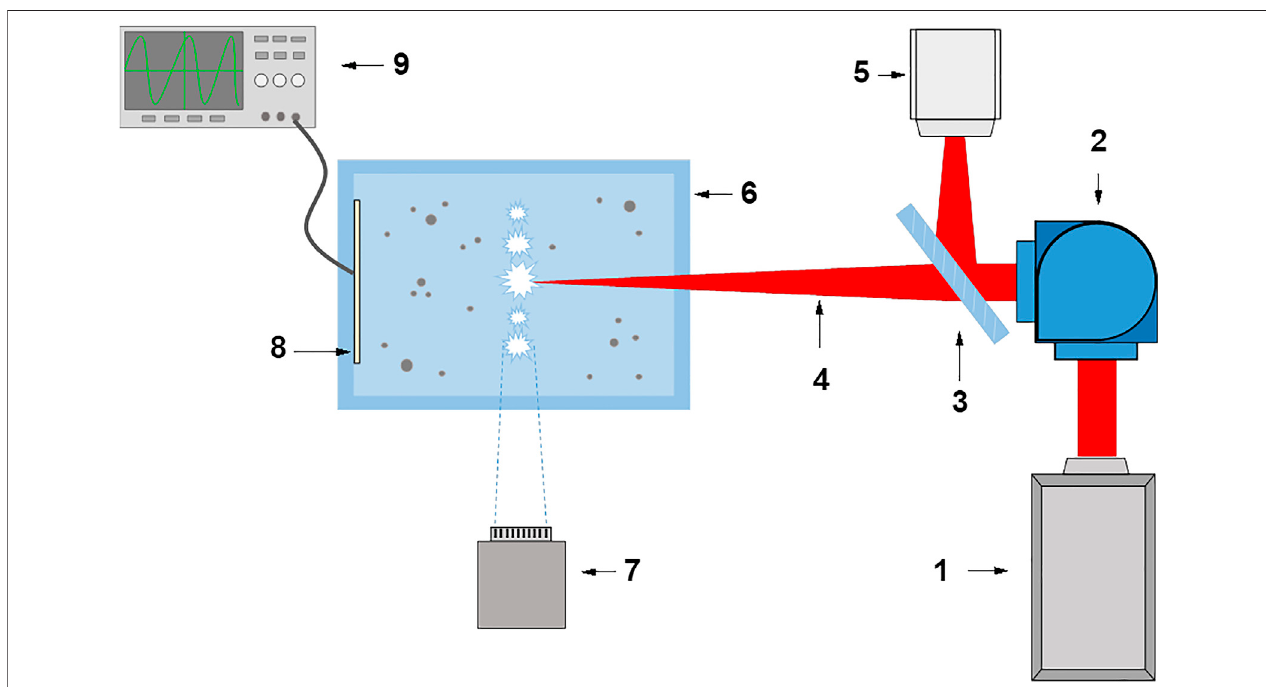
FIGURE 1 | Scheme of the experimental setup: 1 Nd: YAG laser ( λ (cid:1) 1,064 nm, τ (cid:1) 10 ns, ν (cid:1) 10 kHz, ε (cid:1) 2 mJ); 2 Galvano-mirror system; 3 Re fl ective mirror; 4 Laser radiation; 5 Pin photodiode; 6 Cuvette with an aqueous solution of Fe nanoparticles; 7 Pin photodiode; 8 Film piezoelectric sensor; 9 Digital oscilloscope.